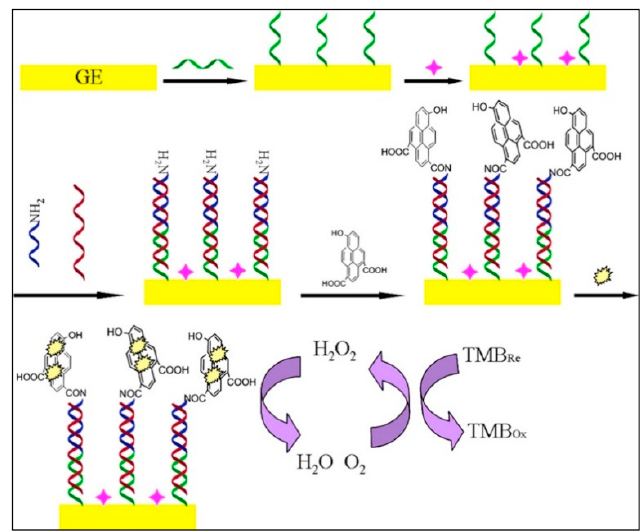
Figure 9. Principle of the enzyme catalytic amplification of miRNA-155 detection with graphene quantum dot-based electrochemical biosensor (reproduced with permission from the publisher) [118].